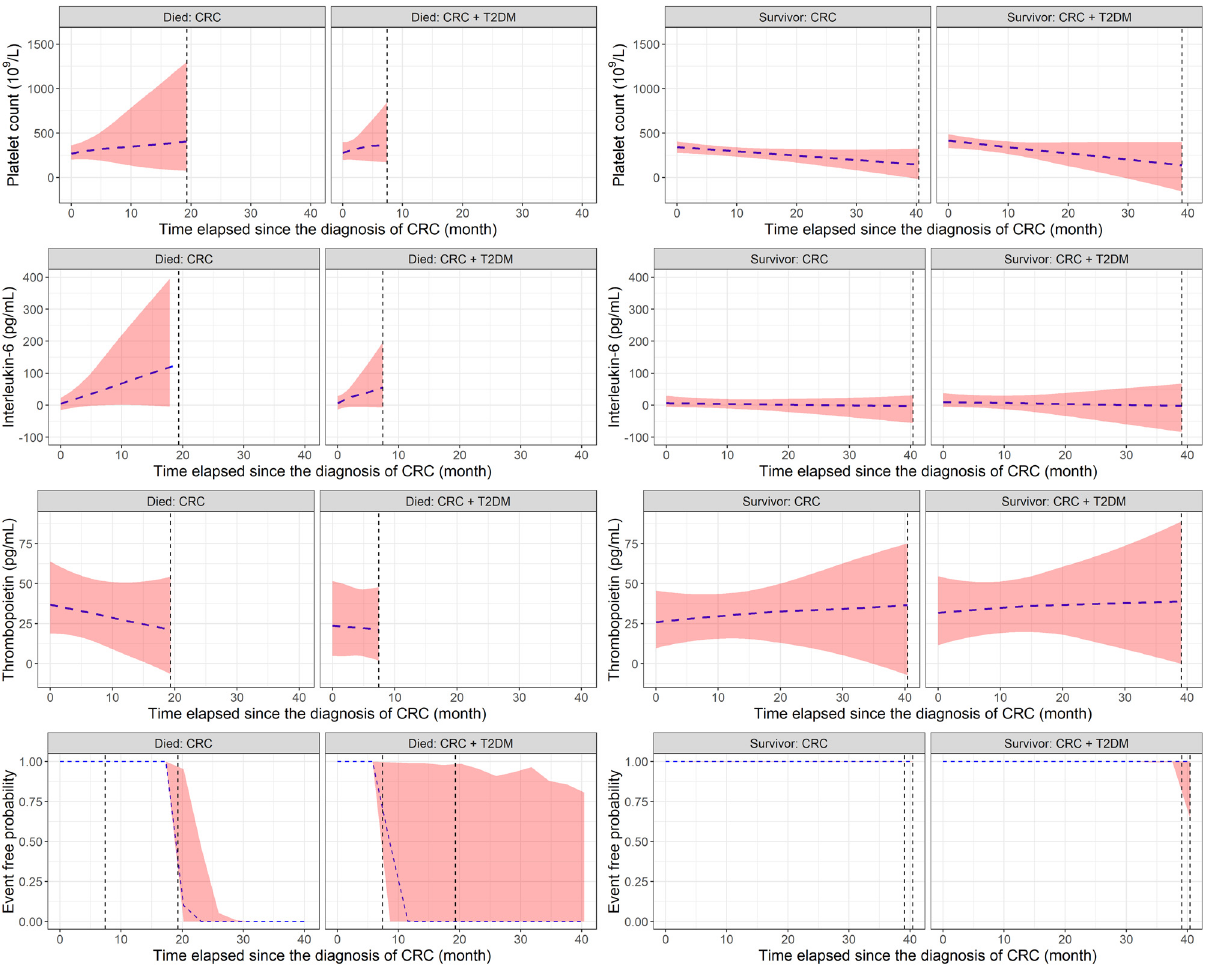
Figure 4: Longitudinal and survival predictions of the Bayesian joint models. No di ff erence was found between CRC patients with or without T2DM. Increasing platelet count and plasma interleukin - 6 level were associated with a higher risk of shorter survival times ( left ) , whereas no change or a slow decline in these parameters is a good prognostic sign ( right ) . Thrombopoietin levels had no clinically relevant e ff ect neither in univariate nor in multivariate survival